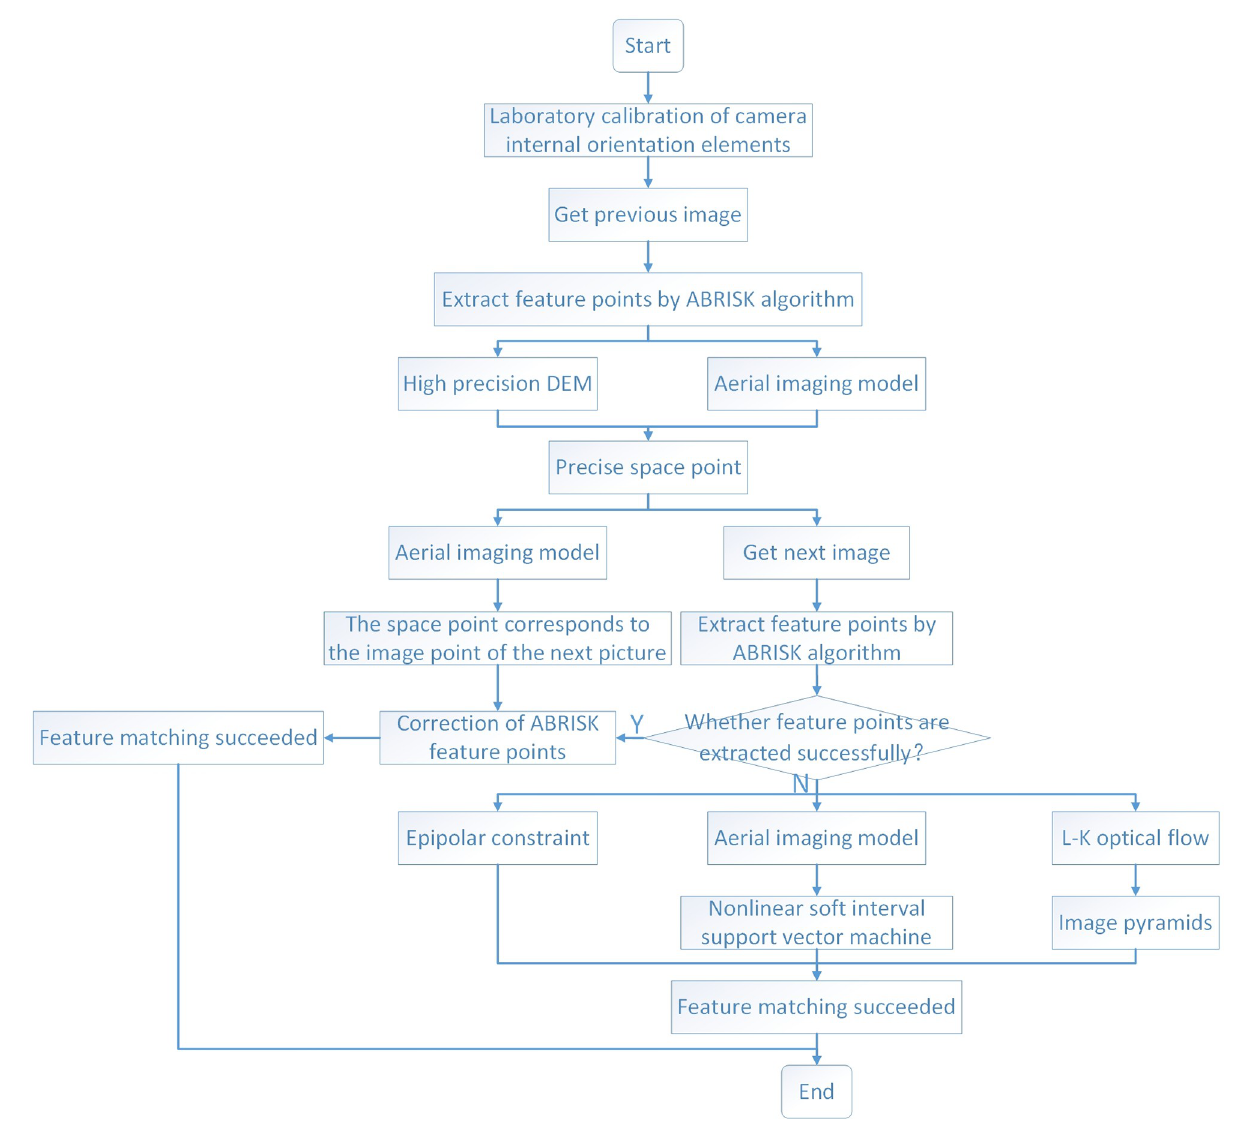
Fig 1. Overall flow chart of